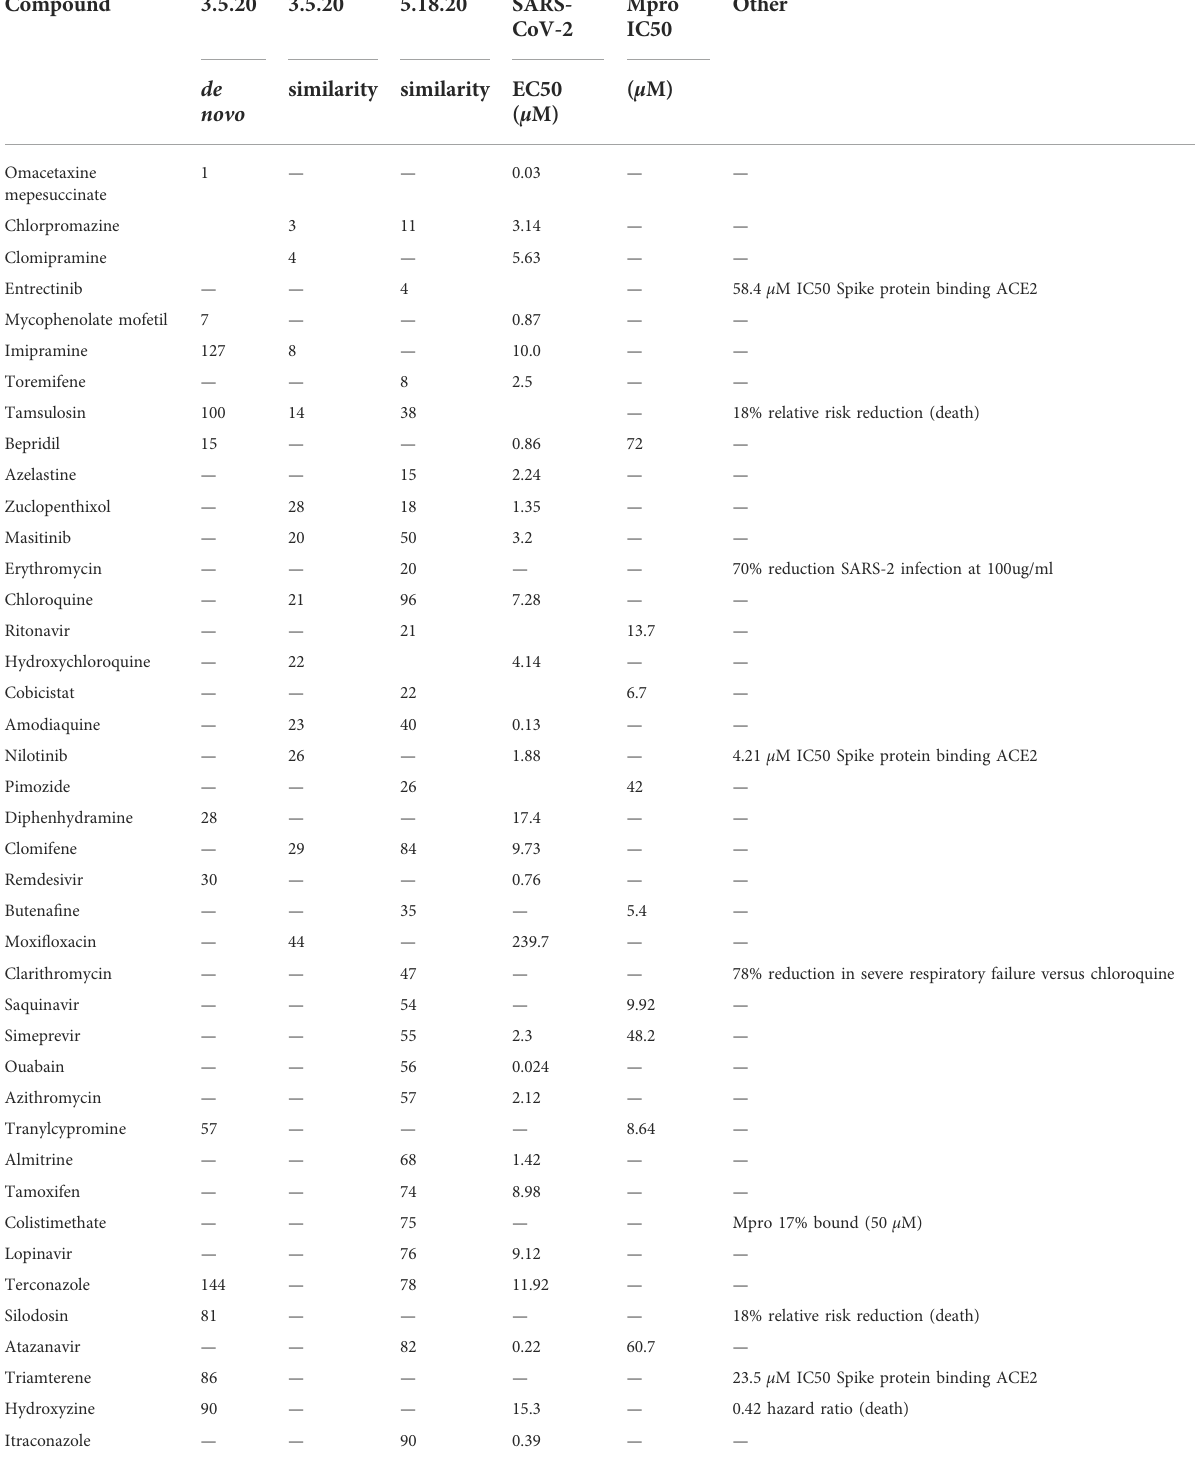
TABLE 2 Complete listof validated candidates generated by the CANDO platform. The names of the 51compounds, their ranks in the 3.5.20 de novo , 3.5.20similarity,and5.18.20similaritylists,thefullvirusEC50s,mainproteaseIC50s,andEHR-basedevidencearegiven.Onlythelowestfullvirus EC50 for each candidate is shown. The de novo pipeline identi fi ed better, more potent, full virus inhibition candidates, while the signature similarity pipeline identi fi ed a greater fraction of validated candidates accurately.